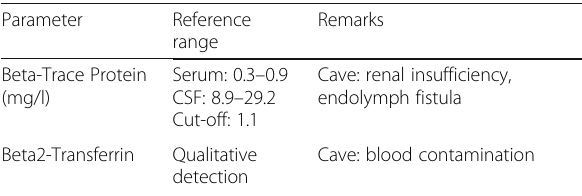
Table 21 Reference ranges of proteins for detection of CSF fistula